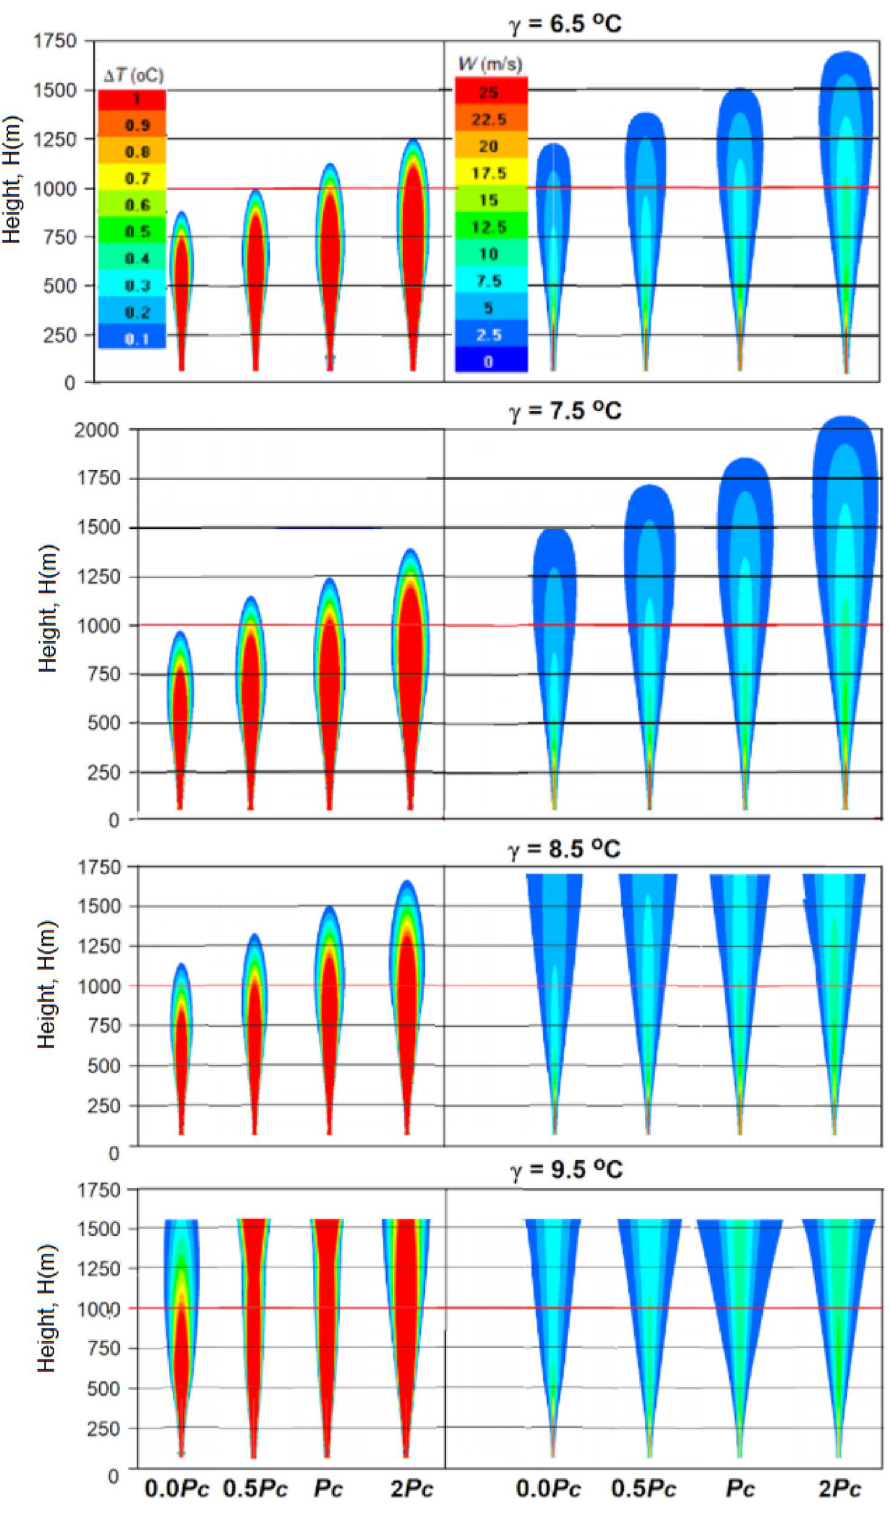
Figure 16. Vertical sections of Δ T and W fields for the jet with feeding P C = 151 MW at γ = 6.5, 7.5, 8.5 and 9.5 °C/km in a windless atmosphere with f = 70%